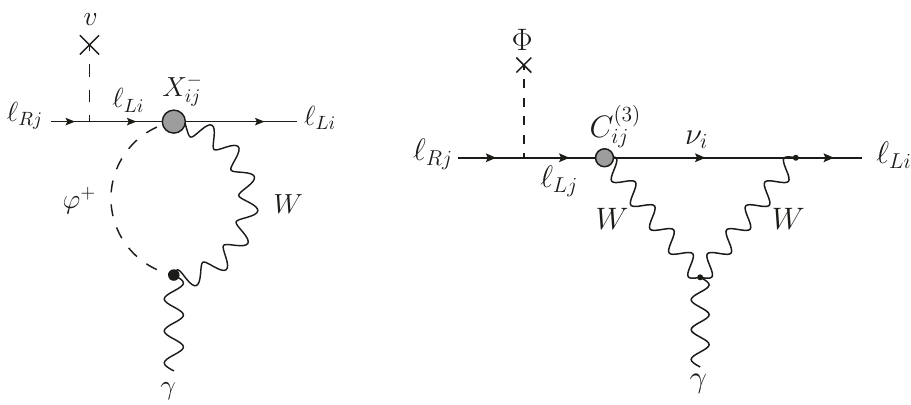
Figure 15. Diagrams with the insertions of the SMEFT operator which receives contributions at tree-level, contributing to ‘ → ‘ 0 γ